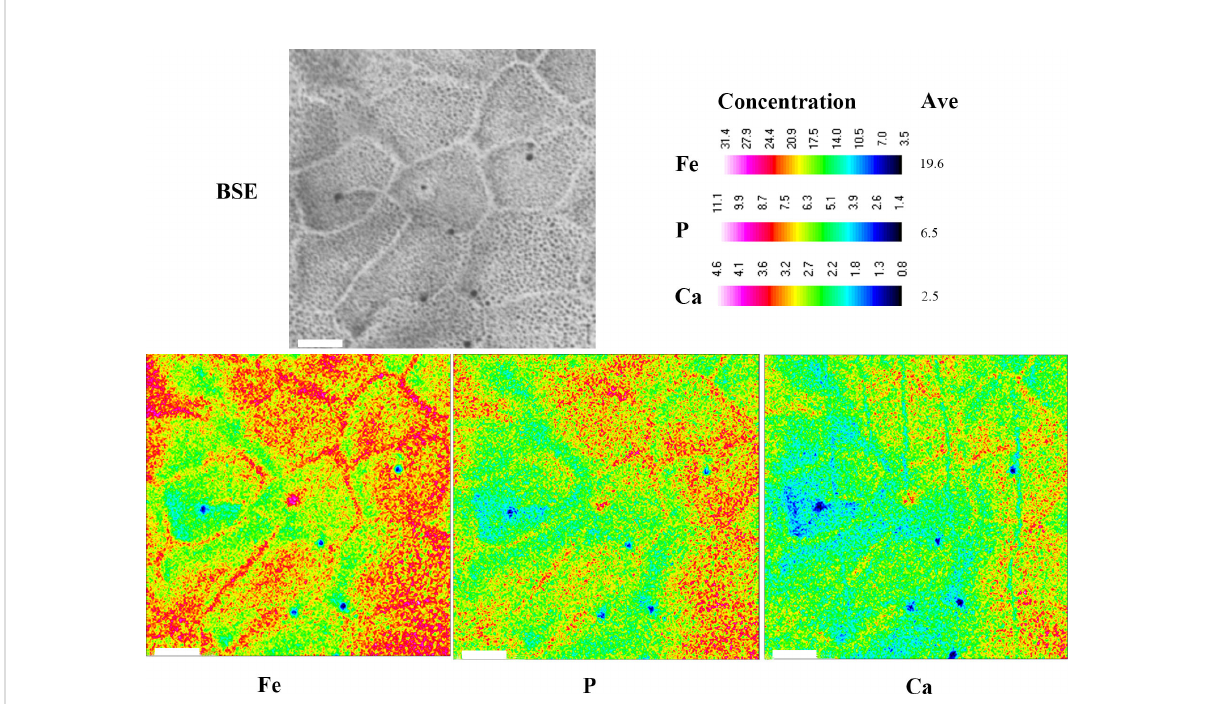
FIGURE 5 Backscattered electron (BSE) images and electron probe microanalysis (EPMA) elemental maps of Fe, P, and Ca for Sternaspis chinensis. Ave, average concentration. Scale bar: 10